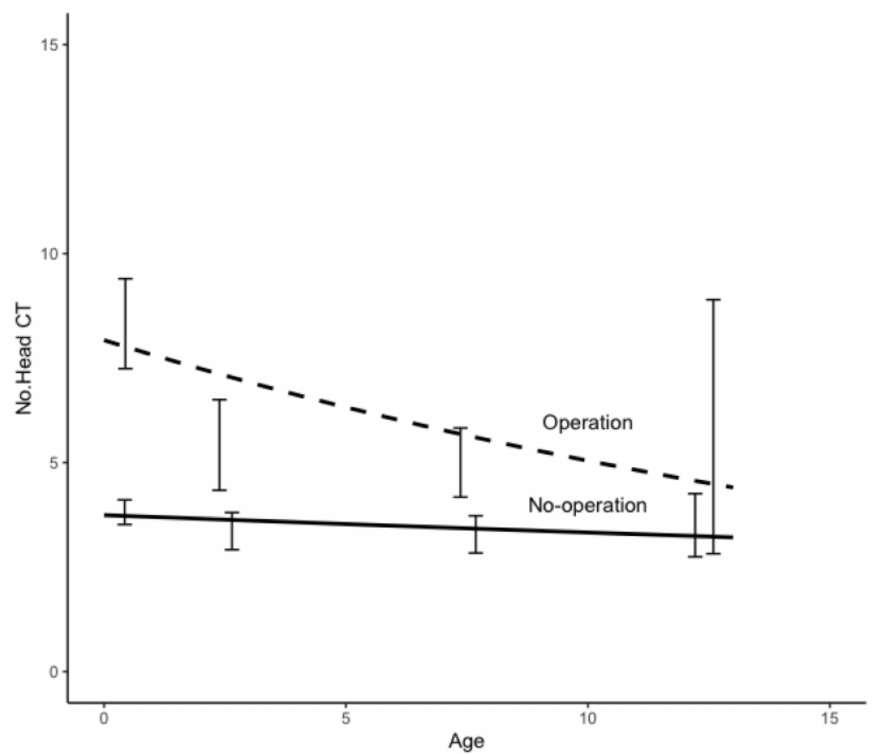
Figure 3. Age dependence of the number of CT examinations in trauma patients with and without surgery. The age is at the time of initial examination.